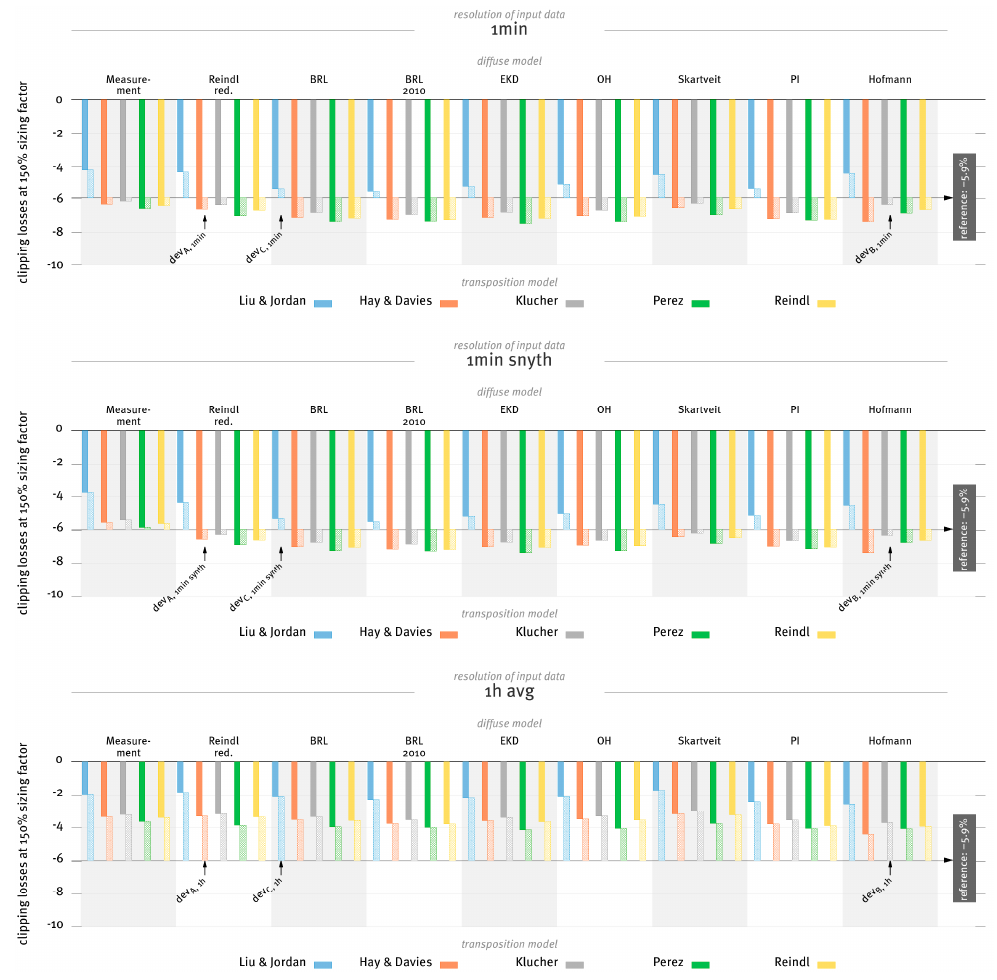
Figure 10. All inverter clipping losses simulated with s sizing factor of 150%. Selected data points (dev A , dev B and dev C ) can be compared to Figure 9. The main bars in full color represent the absolute clipping loss as a result of the simulation with the respective choice of models and input data type. The side bars in light color represent the deviation from the reference. The reference is calculated as the average of the model chains using one-minute data for global and diffuse irradiance.